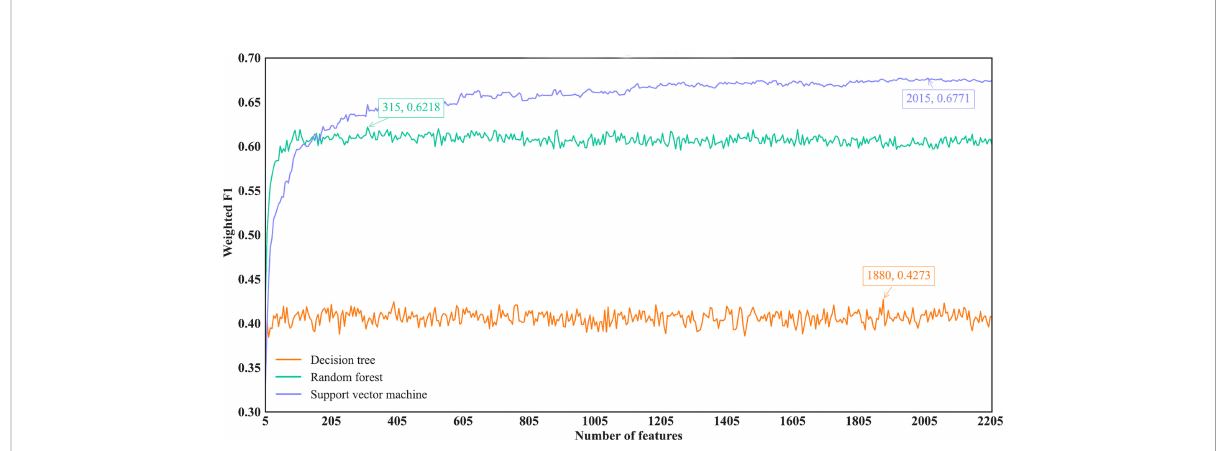
FIGURE 7 IFS curves of different classi fi cation algorithms on the LightGBM feature list. Three classi fi cation algorithms provided highest weighted F1 values of 0.4273, 0.6218 and 0.6771, respectively, based on top 1880, 315 and 2015, respectively, features in the list.